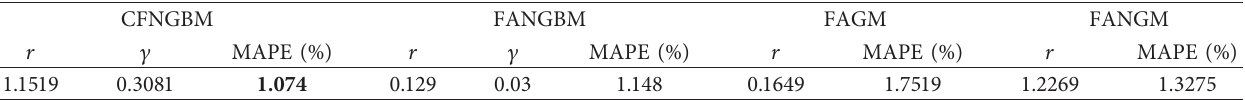
Table 6: The minimum MAPE and optimal order, power index of FAGM(1,1), FANGM(1,1, k , c ), FNGBM(1,1), and CFNGBM(1,1), and CO emissions in India.